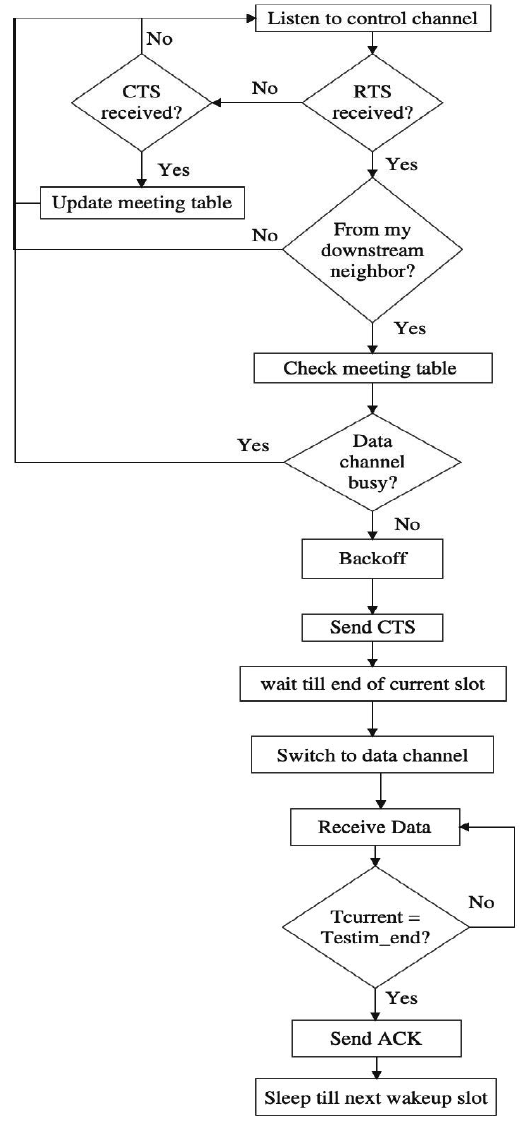
Figure 11. Receiver behavior.